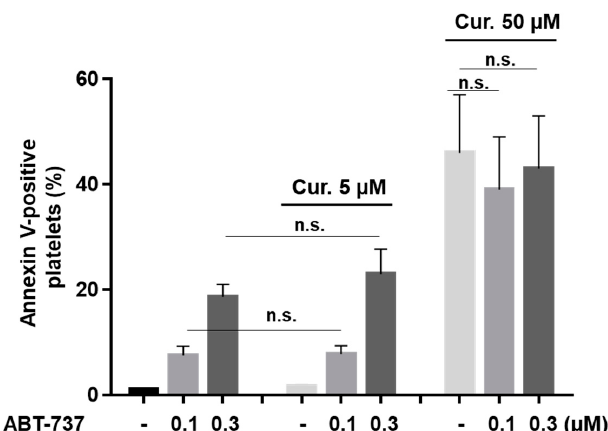
Figure 5. Curcumin had no effect on ABT-737-induced phosphatidylserine surface exposure. Washed platelets (1 × 10 8 /mL) were incubated with indicated concentrations of ABT-737 in the absence or presence of curcumin (5, 50 µM) and PS-positive platelets (annexin-V-PE binding) were analyzed by flow cytometry, Data are presented as means ± SD, n = 6. Paired t-test p = 0.52, p = 0.13; and one-way ANOVA, Levene’s test p > 0.05 followed by Tukey’s HSD test, p = 0.678, p = 0.871, n.s.—not significant.